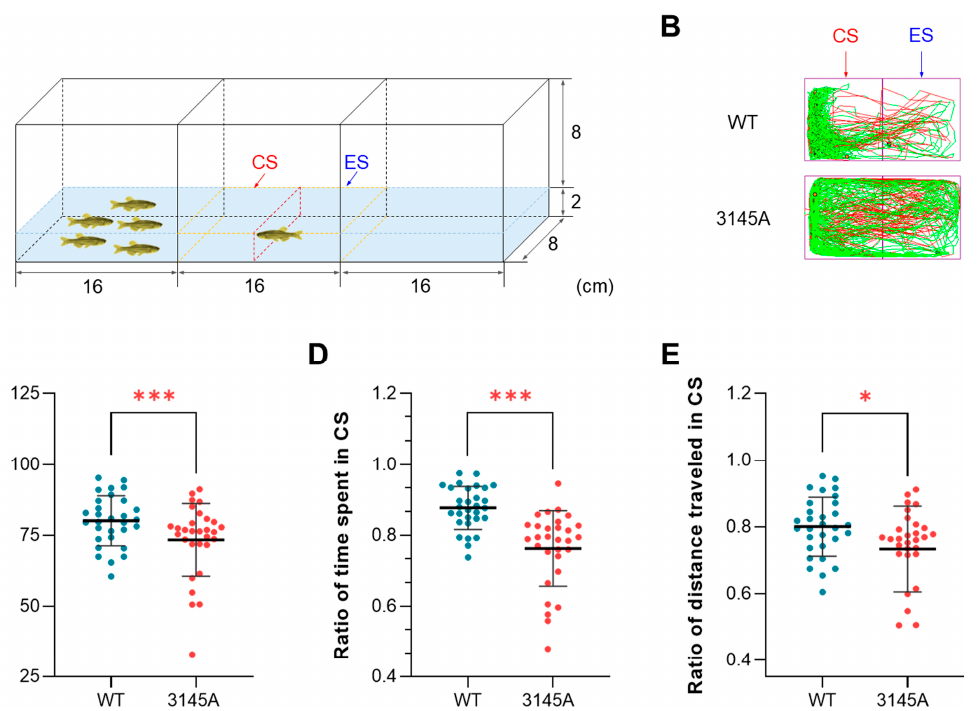
Figure 5. Dysfunction of Prkcaa attenuated the social preference of zebrafish. ( A ) A diagram for the social preference test. The region enclosed by the dashed yellow line is the video recording area, which is divided into the conspecific sector (CS) and the empty sector (ES) in the middle (the dashed red line). The numbers indicate the size of the tank (cm). ( B ) Representative tracked trajectories of the WT and 3145A fish. The red and green line segments represent large (> 15 cm/s) and moderate (1–15 cm/s) movements, respectively. ( C ) Social preference value. ( D ) Ratio of time spent in the CS. ( E ) Ratio of distance traveled in the CS. The error bars represent standard error ( n = 30). *, p < 0.05; ***, p < 0.001.